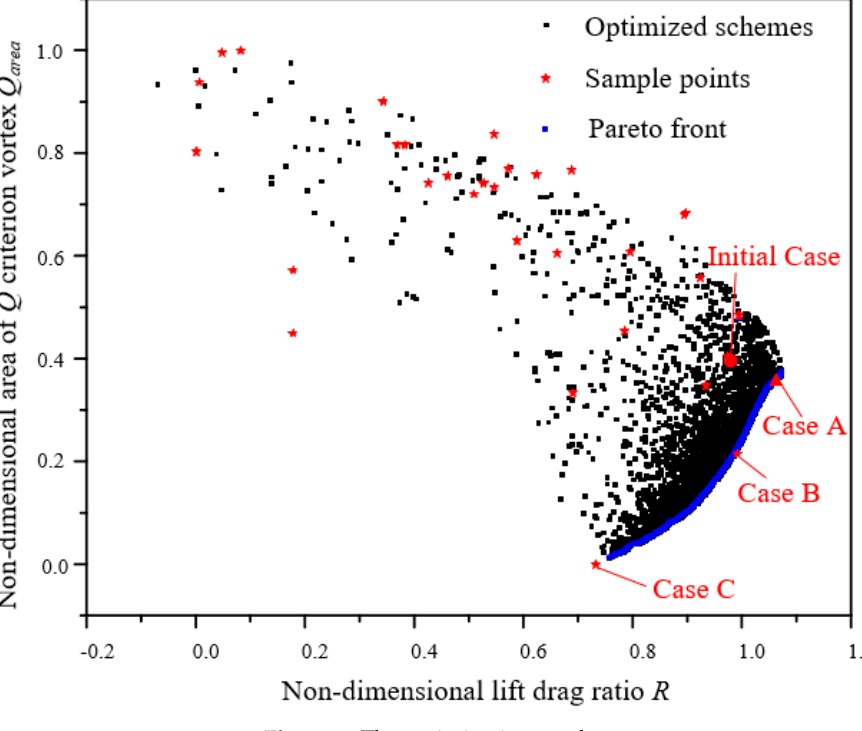
Figure 6. The optimization results.